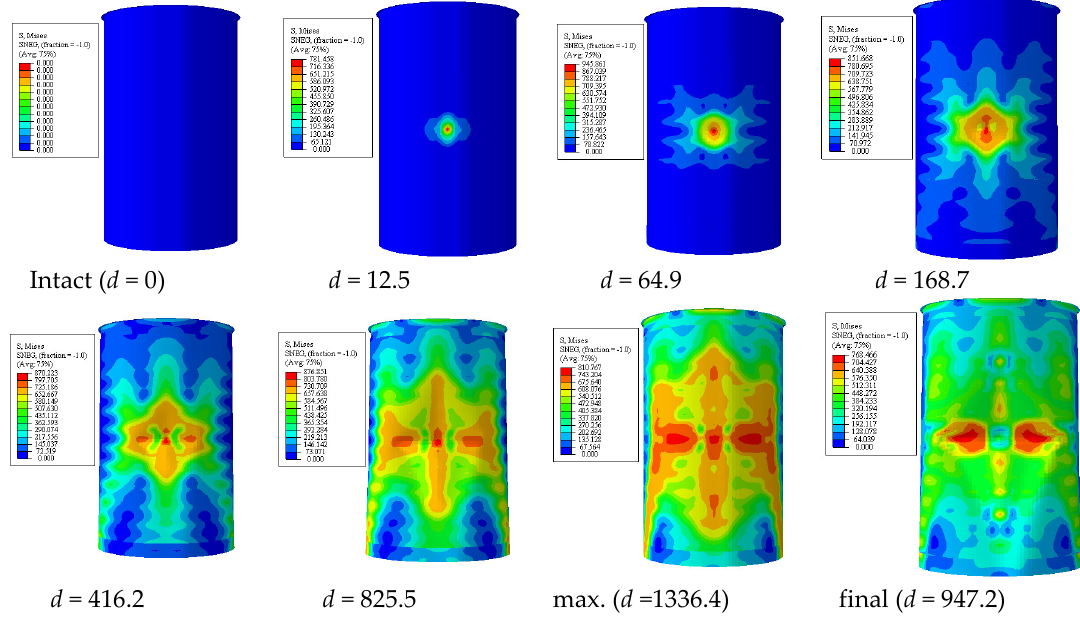
Figure 15. Typical deformation progress under collision load of model RS-3 (units: mm).